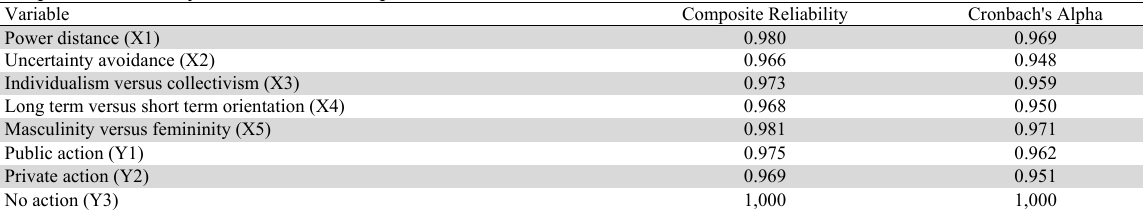
Composite Reliability and Cronbach's Alpha Coefficient Variable